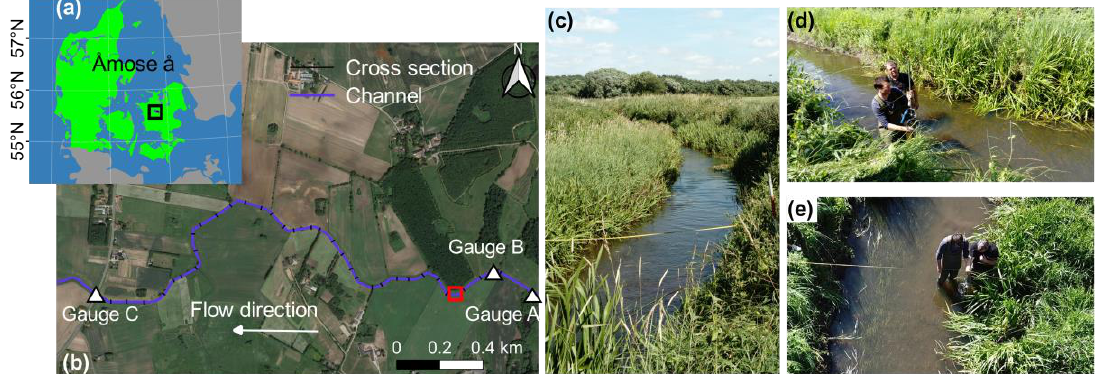
Figure 1. Field site and channel views. ( a ) Map showing the study area (Åmose å) in the western part of Zealand, Denmark. ( b ) The studied reach of Åmose å. ( c ) A photograph showing the upstream view. ( d ) A photograph showing the side view of the channel. ( e ) A photograph showing the top view of the channel. Photos were taken on 19 June 2018 at the site, indicated by red rectangle in ( b ).